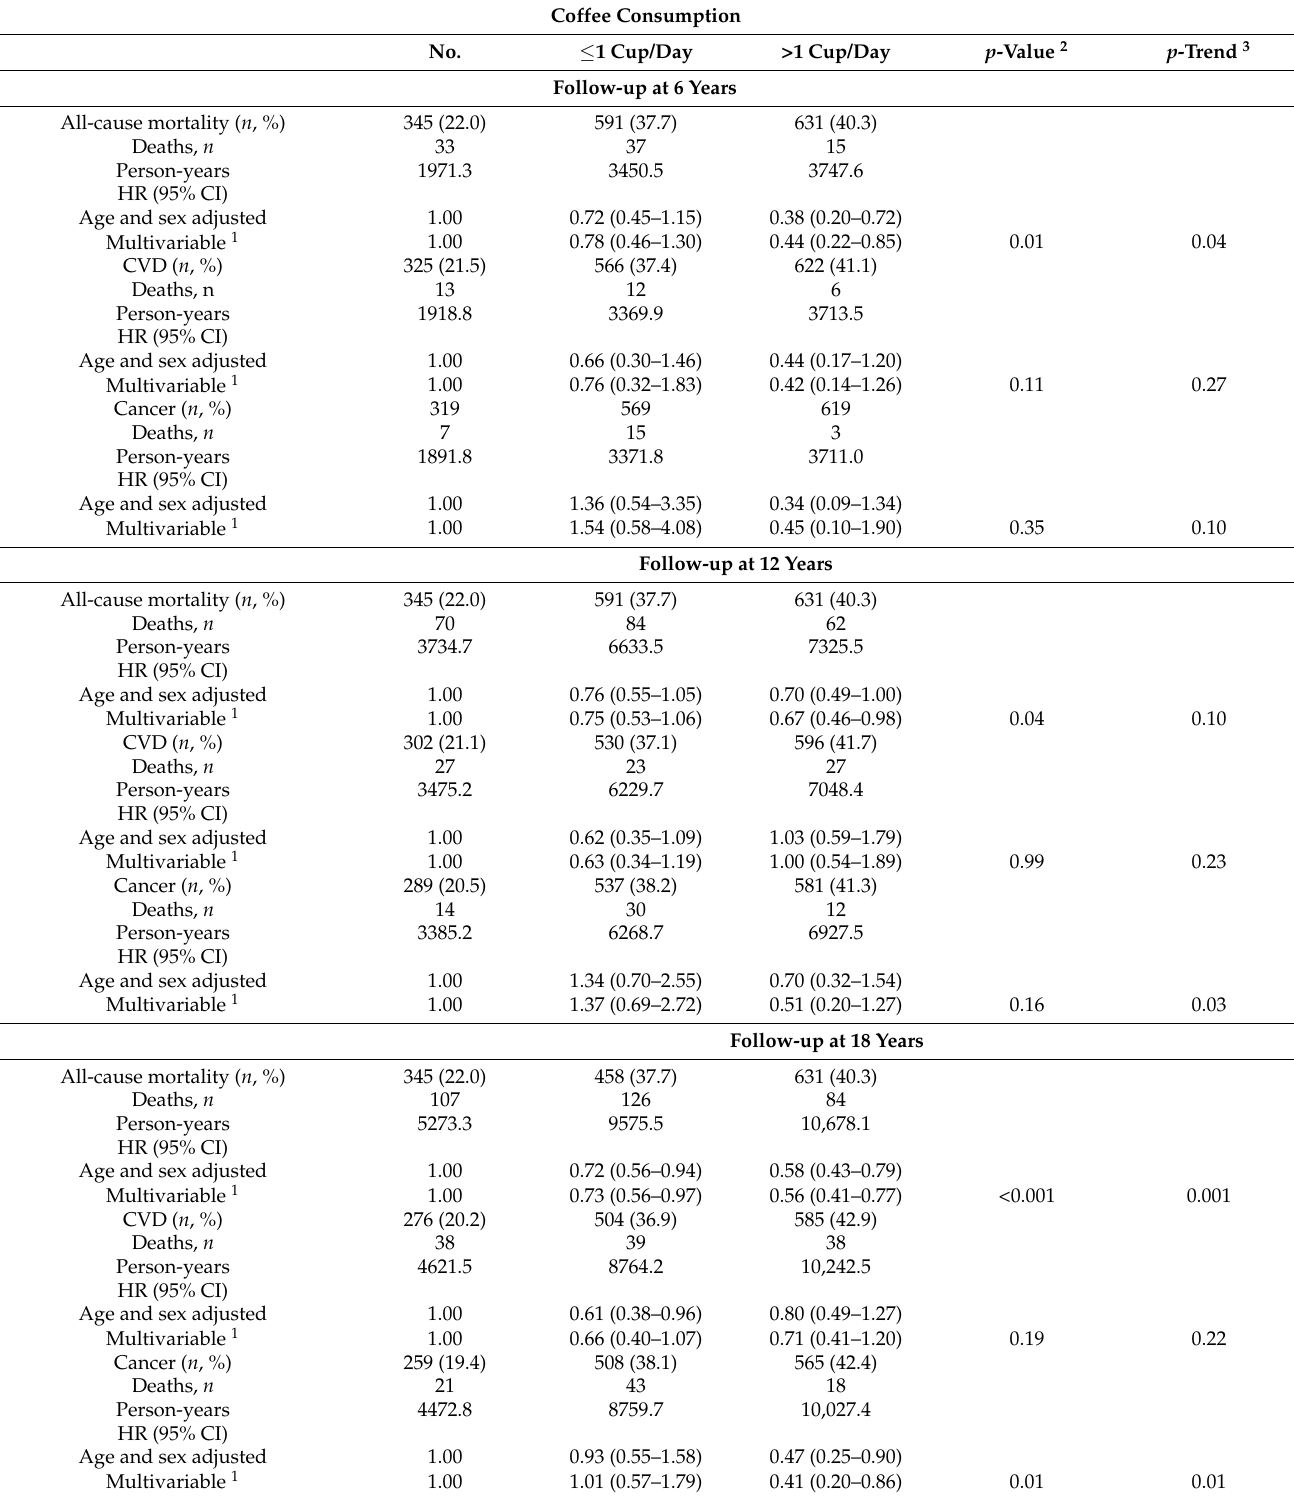
Table 2. Associations between the level of total coffee consumption and all-cause, cardiovascular disease, and cancer mortality among participants of the Valencia Nutrition Survey in